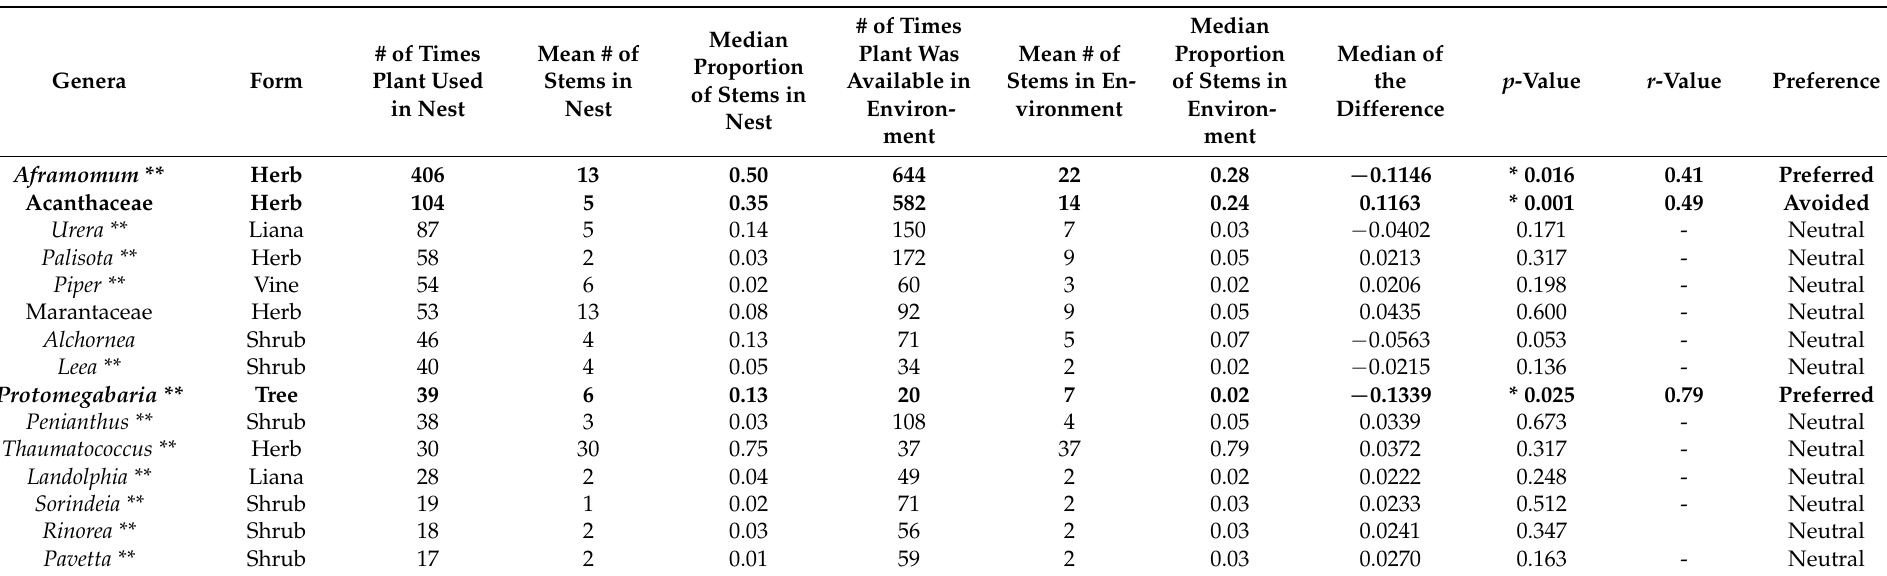
Table 6. Mean and median number of nest stems and proportion of the 15 most commonly used plant genera within night nests constructed by gorillas, and the two-metre radius around the nest. Note: * denotes statistical significance; ** denotes species recorded in diet of Mone-Oku gorillas [36].